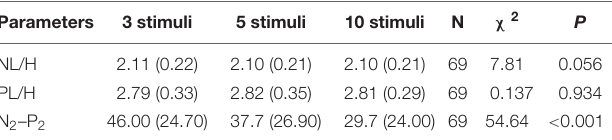
TABLE 2 | Results of contact heat evoked potential stimulation of the right forearm with three, five, and ten stimuli. Parameters